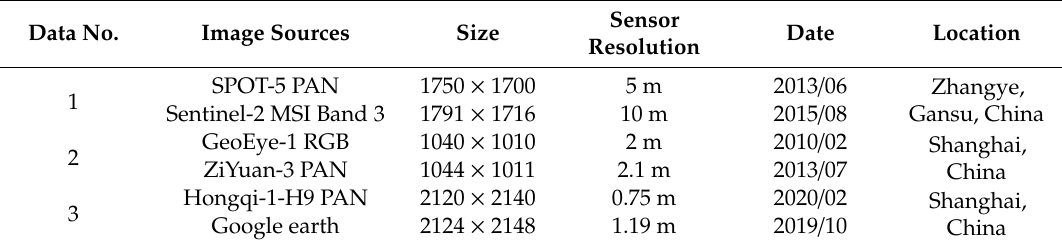
Table 4. Basic information about the images used in the fine registration experiment. Data No. Image Sources